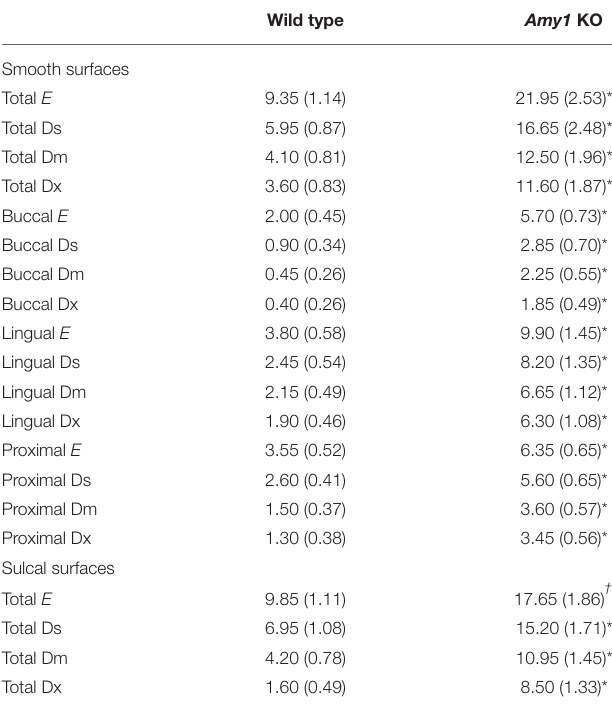
TABLE 1 | Development of caries and their severities on molars comparing wild-type mice with Amy1 knockout (KO) mice. Wild